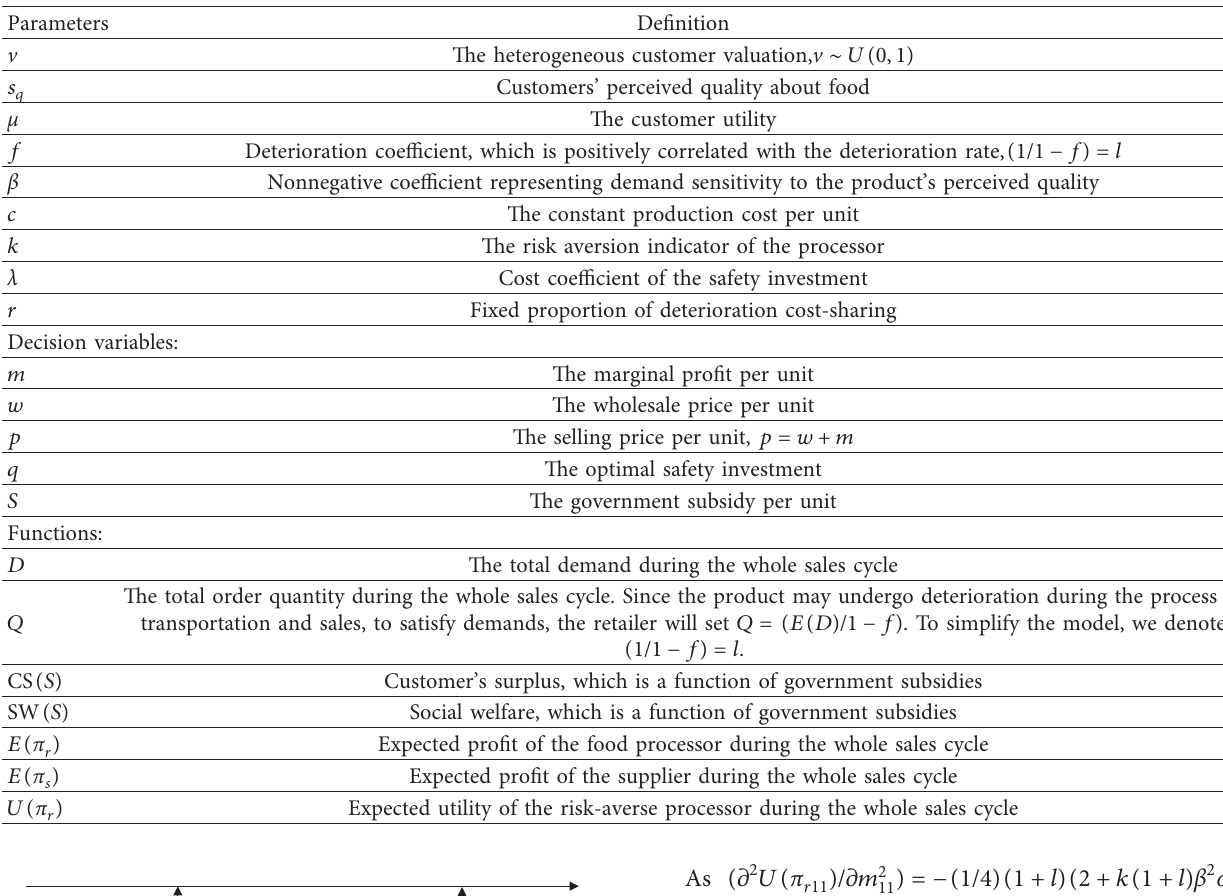
Table 1: Notation and explanation.